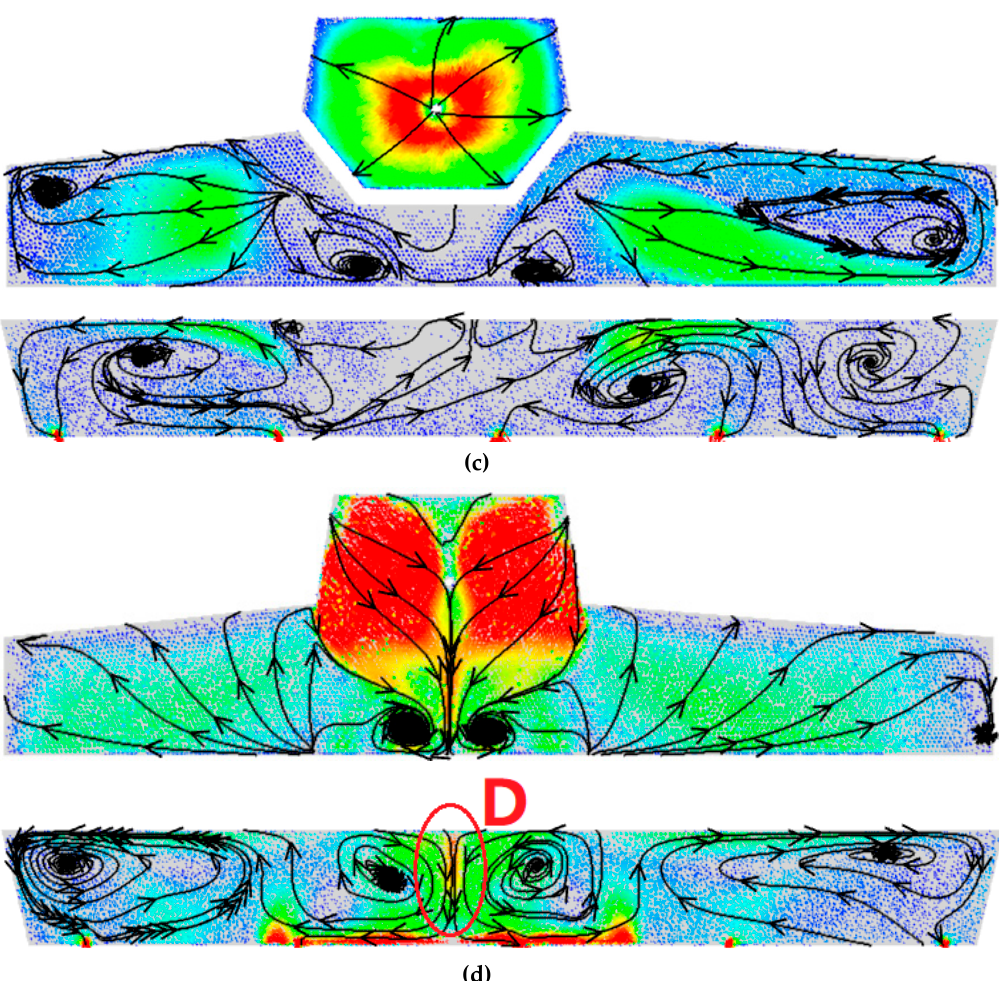
Figure 8. The velocity and vector distributions in the tundish for a longitudinal cross-section according to different internal structures. ( a ) The 50 mm − 20° arrangement; ( b ) 70 mm − 20° to di ff erent internal structures. ( a ) The 50 mm − 20 ◦ arrangement; ( b ) 70 mm − 20 ◦ arrangement; arrangement; ( c ) 90 mm − 20° arrangement; and ( d ) original arrangement. ( c ) 90 mm − 20 ◦ arrangement; and ( d ) original